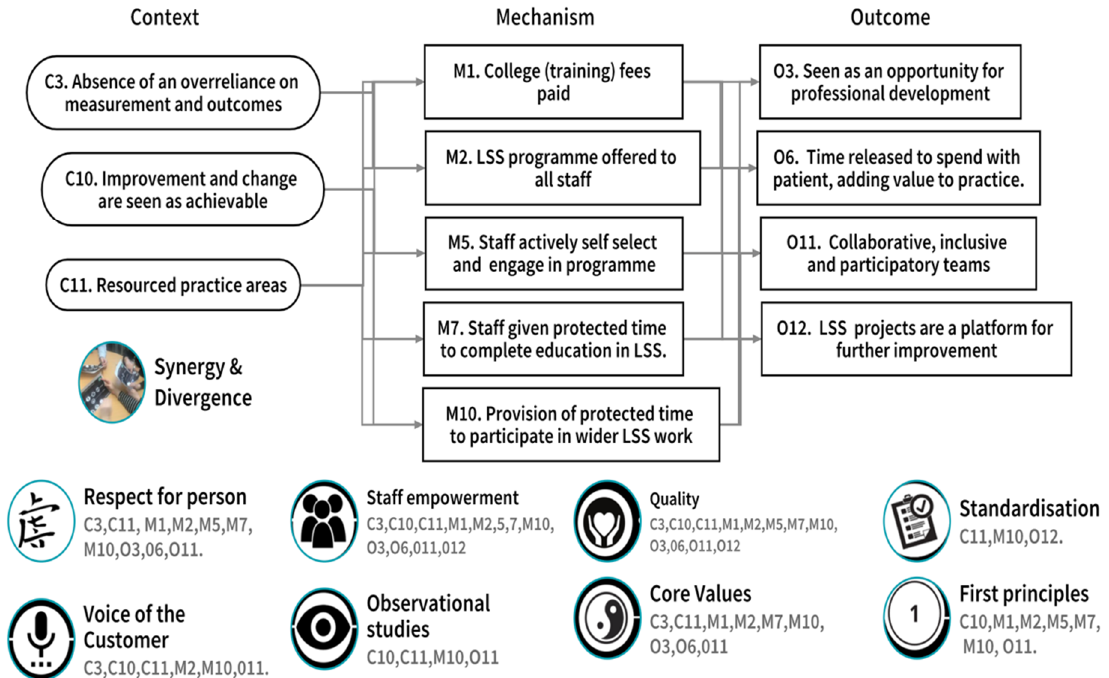
Figure 6. CMOc2 The organisation’s receptivity to LSS.